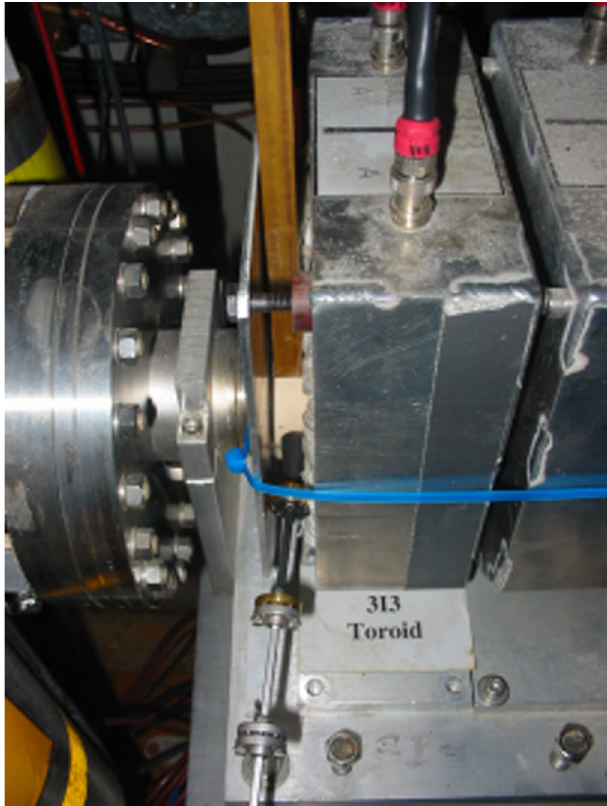
FIG. 6. (Color) Photograph of the waveguide installation at a ceramic gap in the beam line. Two waveguides can be seen in this picture: the upper one for transporting the lower frequency signals, and the lower, including a small horn, for coupling to the high frequency